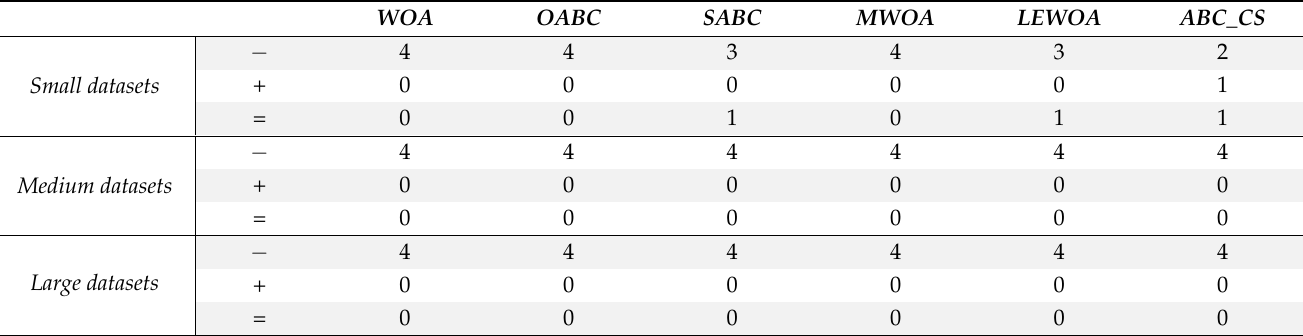
Table 4. p -values of IWOA compared to other algorithms obtained from Wilcoxon’s rank-sum test. WOA OABC SABC MWOA LEWOA ABC_CS Small